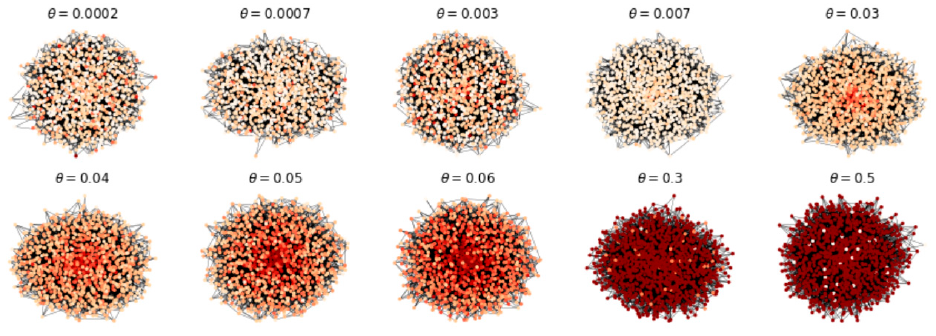
Figure 5. Impact of policy dissemination rate on the evolution of FSN.